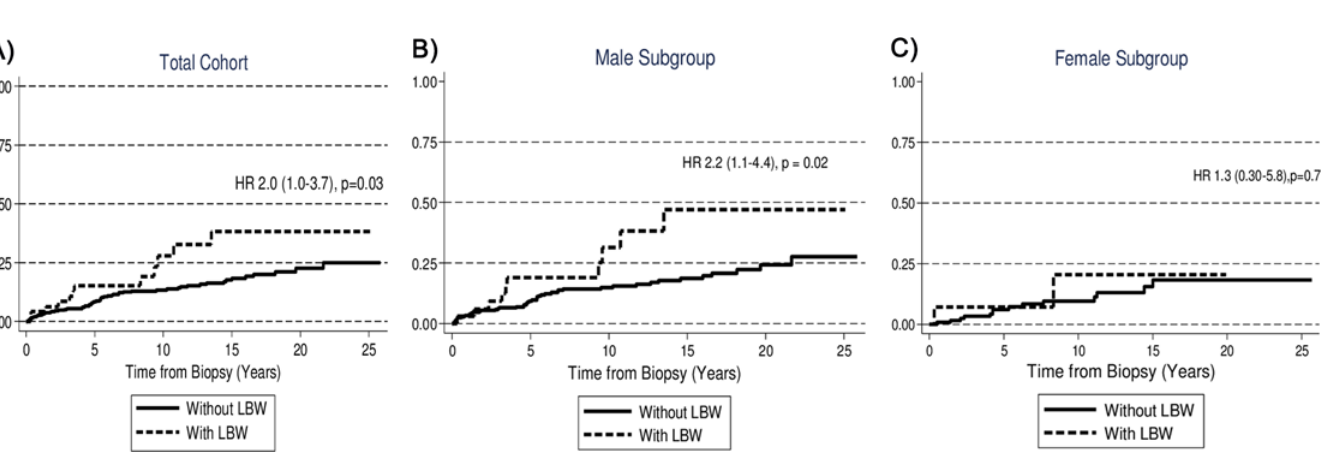
Single versus multiple adverse birth-weight related outcomes and risk of ESRD From the analyses presented in Tables 2 and 3, SGA was associated with slightly higher hazard ratios for ESRD as compared to LBW. Preterm birth was on the other hand not associated with